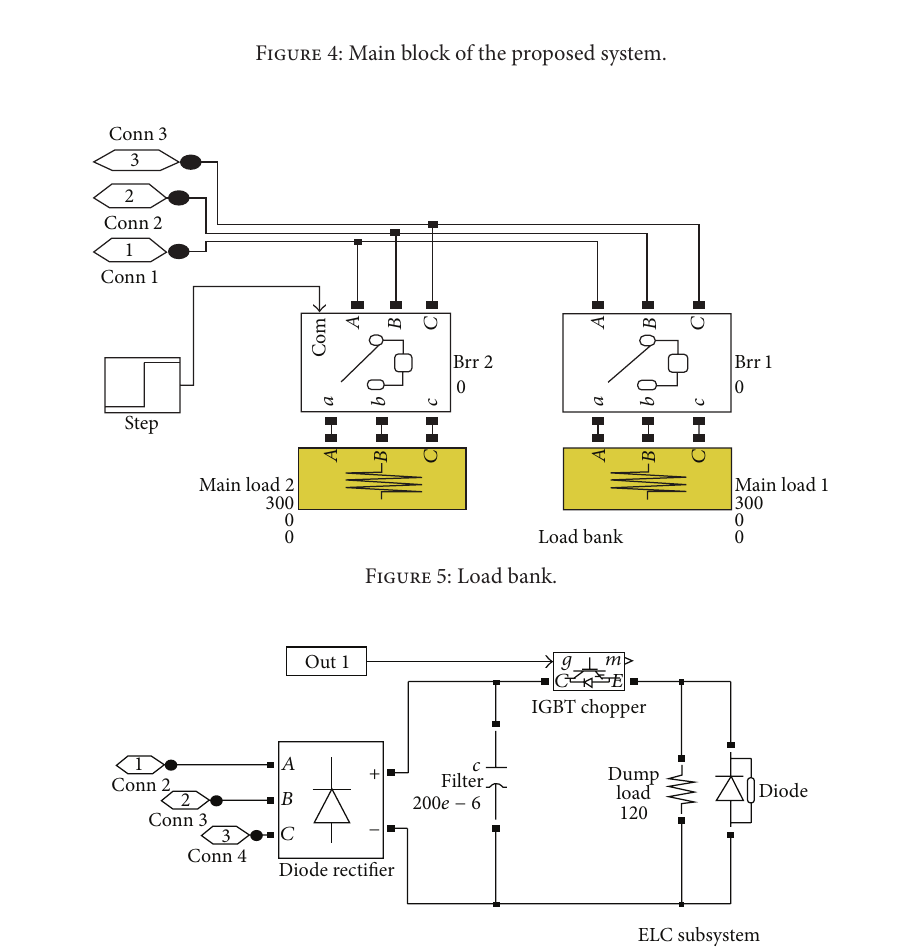
Figure 5: Load bank.